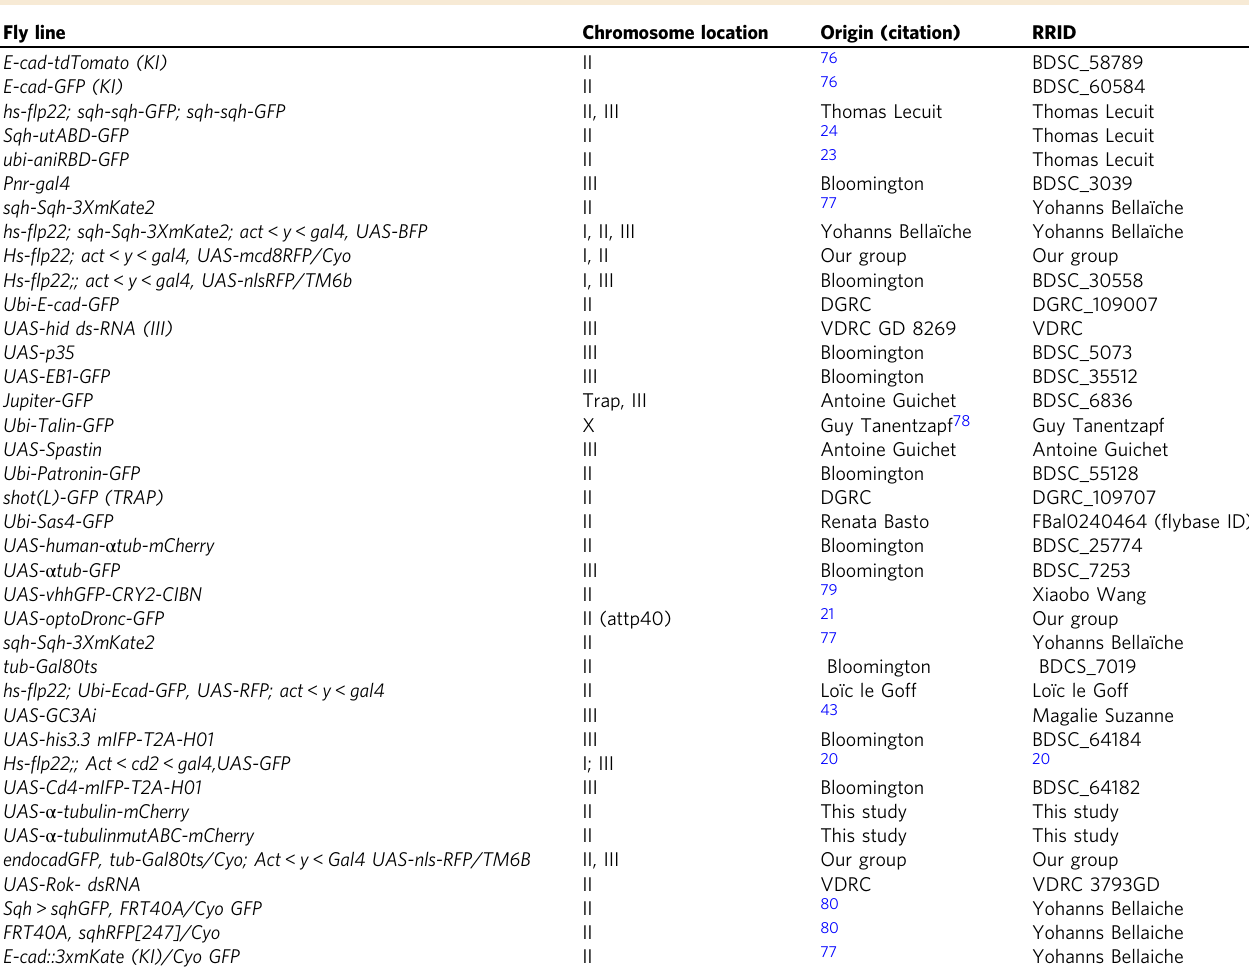
Table 1 Drosophila melanogaster strains used in this study.